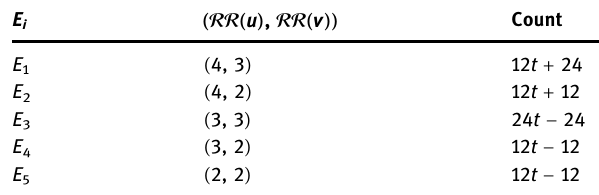
Table 1: Reduced degree edge partitions of MOF 1 ( t )